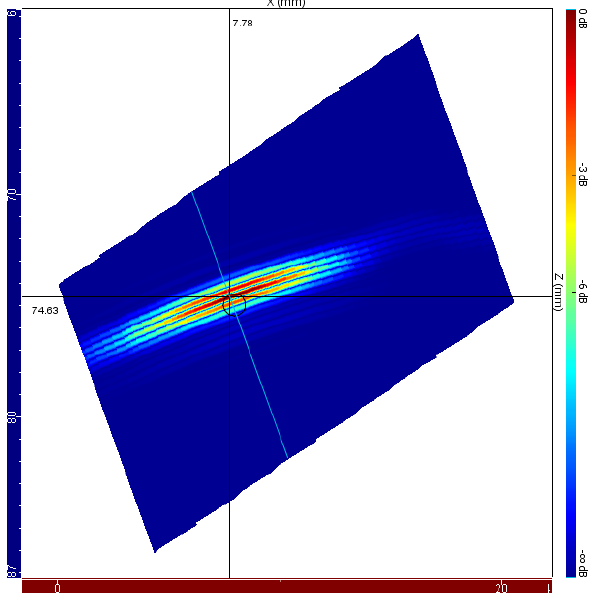
Figure 8. Ultrasonic E-Scan image of the side-drilled hole for the case with no temperature gradients throughout the wedge. It is taken in the initial instant of the inspection procedure and is used as a reference to establish location and positioning errors due to high-temperature effects.